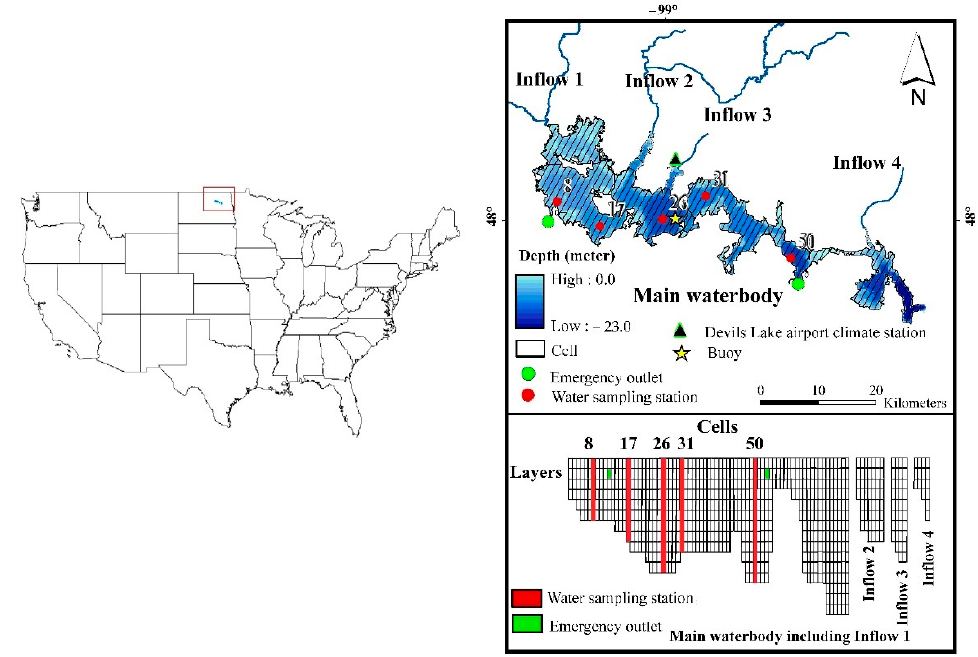
Figure 1. Map of Devils Lake and its discretization in the CE-QUAL-W2 model [17]. The five red points and rectangles represent the locations for seasonal water-temperature sampling. The two green circles and rectangles represent the two emergency outlets. The black triangle represents the location of a weather station, and the yellow star represents the location of the buoy in 2015.